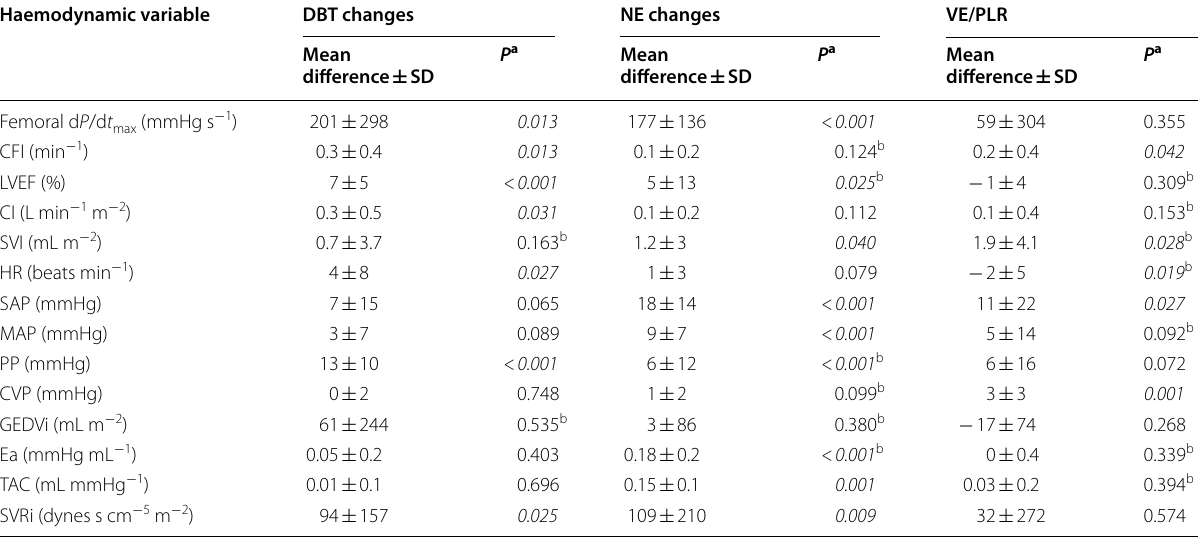
Table 3 Changes in haemodynamic variables during monitored